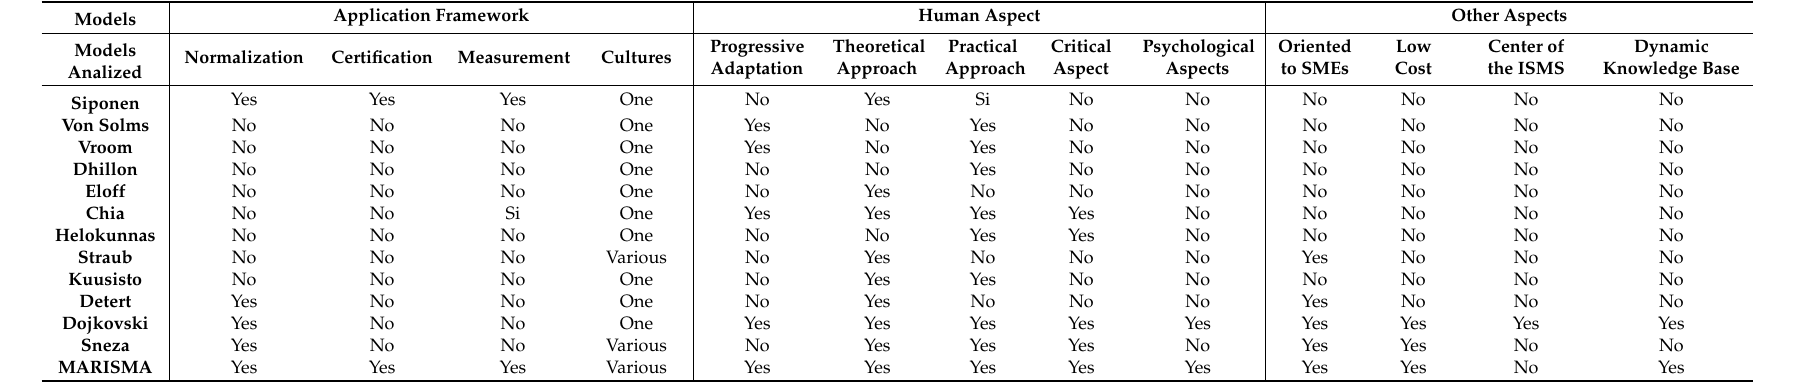
Table 1. Comparative between researches about the security